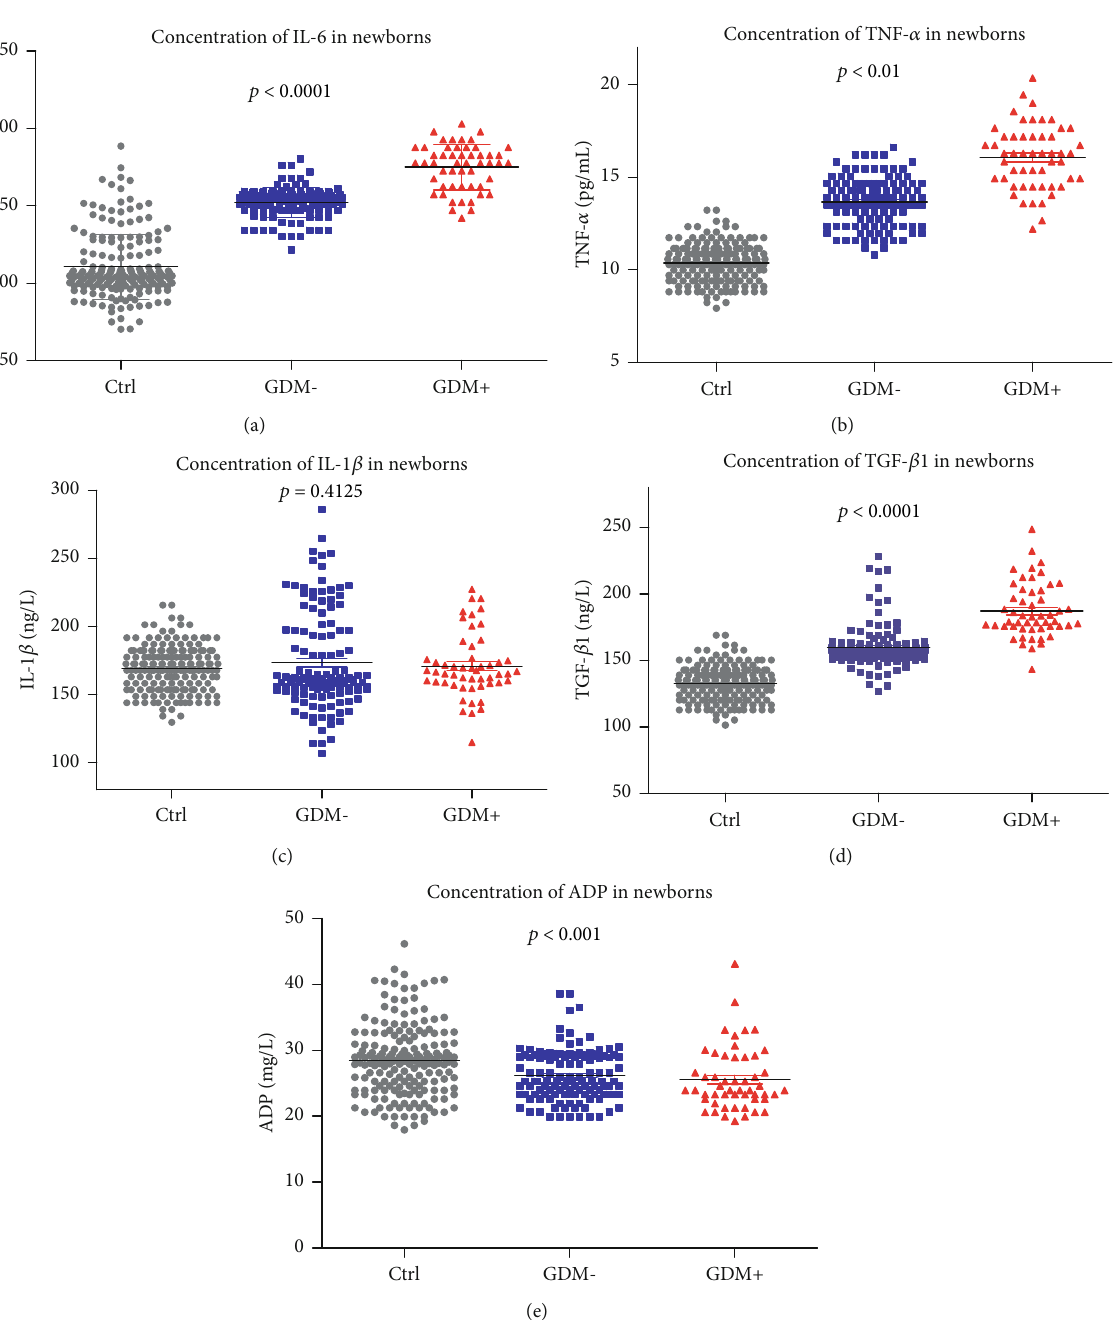
Figure 4: The level of glucose in fl uenced the in fl ammatory cytokines TNF- α , IL-1 β , IL-6, TGF- β 1, and ADP in newborns. (a) The expression of IL-6/TNF- α was increased among the control, GDM-, and GDM+ groups. (c) The expression of IL-1 β showed no di ff erences among the control, GDM-, and GDM+ groups. (d) The expression of TGF- β 1 was increased among the control, GDM-, and GDM+ groups in newborns. (e) The expression of ADP was decreased among the control, GDM-, and GDM+